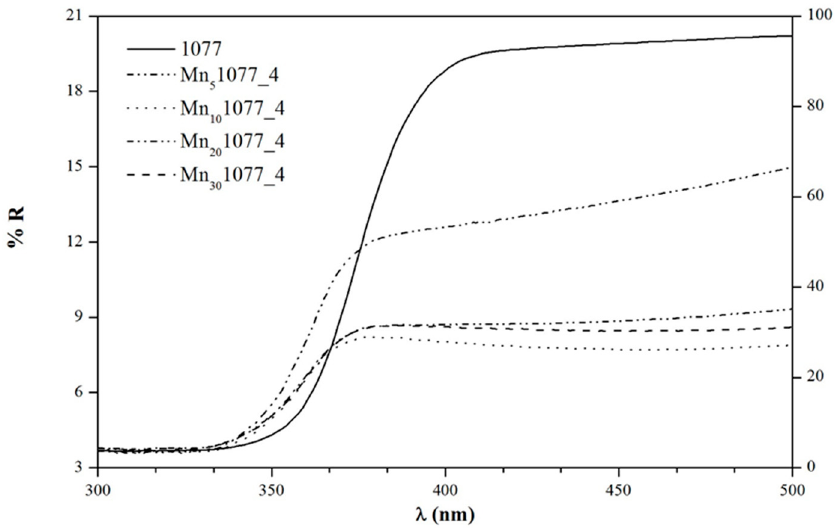
Figure 3. Diffuse reflectance spectra of impregnated TiO 2 powders with different Mn-dopant concentrations.